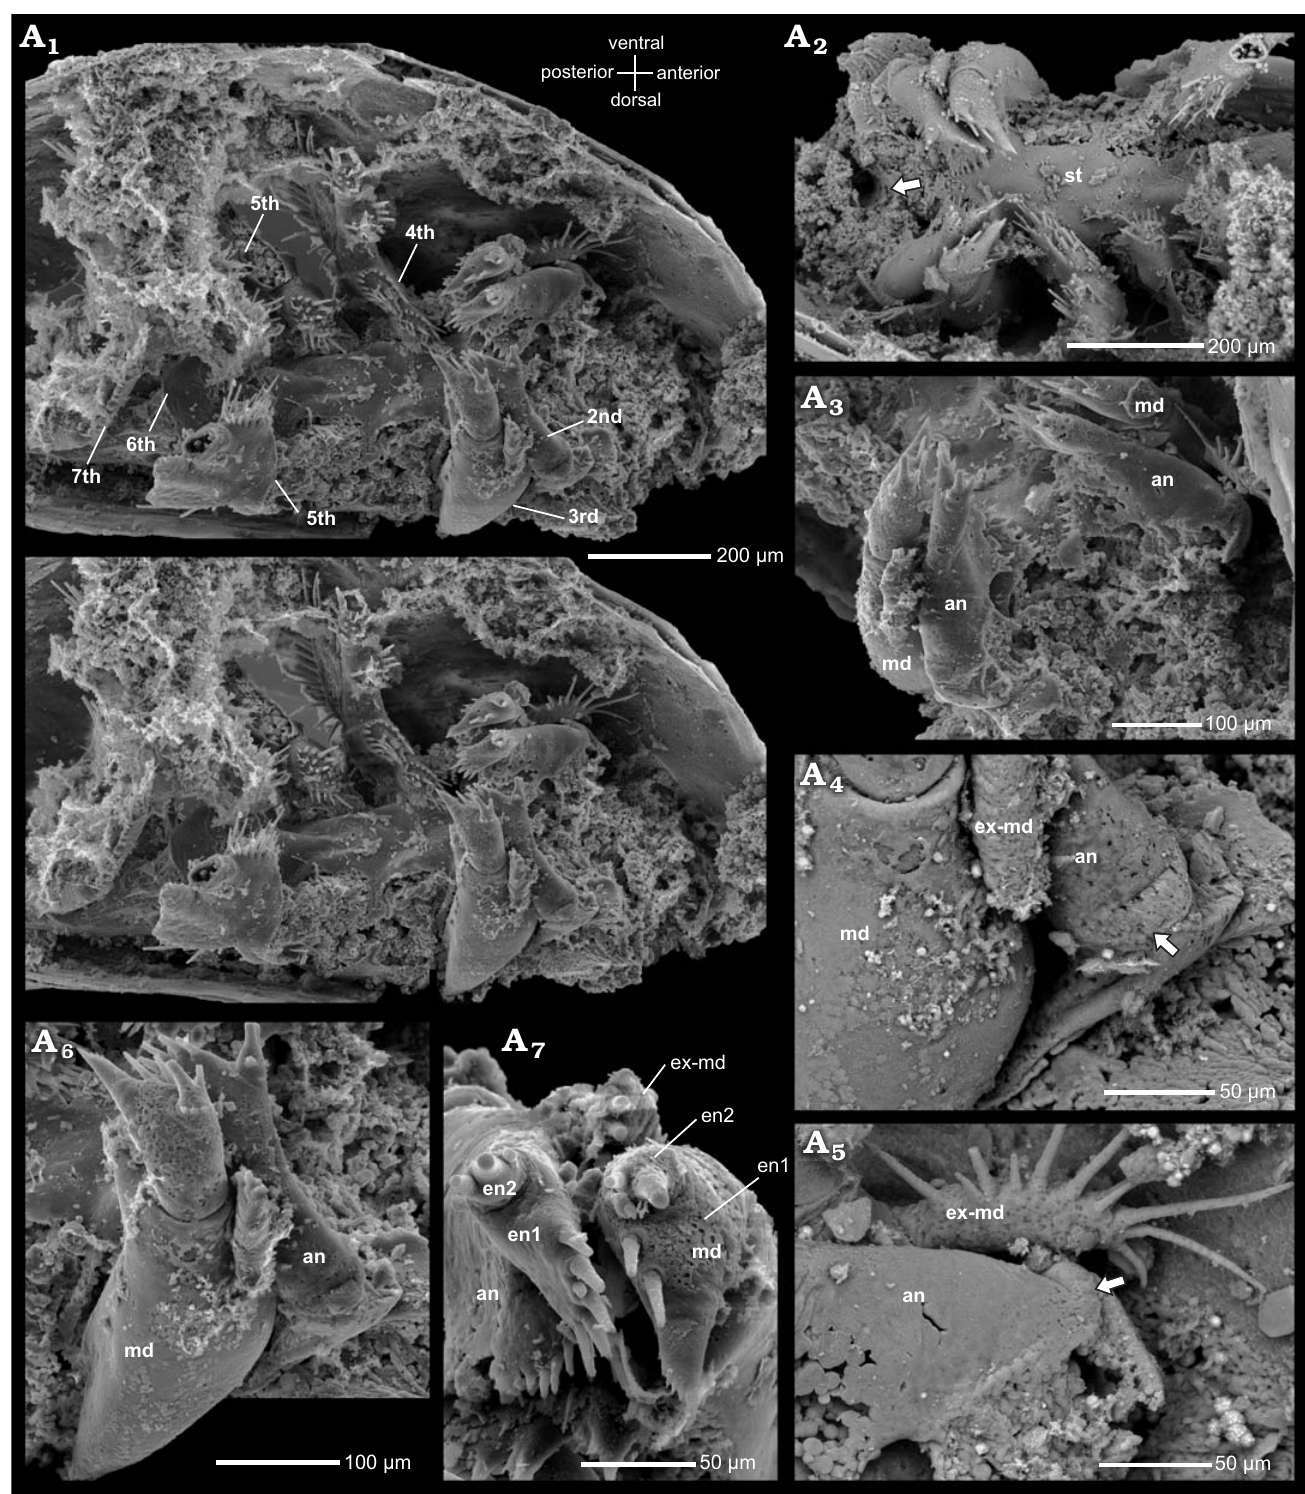
Fig. 3. Phosphatocopid crustacean Cyclotron angelini (Linnarsson, 1875), ZPAL Cr.11/ph060 from the Olenus Biozone, Furongian, D ę bki 2 borehole, northern Poland. Stereo-pair in ventro-lateral view side (A 1 ); ventral view exhibiting pairs of antennae and mandibles, first right post-mandibular limb and remains of second and third post-mandibular limbs, putative gut tube indicated by arrow, anterior to the left (A 2 ); pairs of antennae in anterior view, mandibles with reduced exopods partly visible (A 3 ); BSE image highlighting proximal part of the left antenna with ring-like structure at its base (arrow) (A 4 ); BSE image depicting proximal part of the right antenna in anterior view, with basal ring-like cuticular plate (arrow) (A 5 ); left mandible and antenna in postero-lateral view (A 6 ); left antenna and mandible in ventral view (A 7 ). Abbreviations: an, antenna; en, endopod; ex-md, exopod of the mandible; lst, limb stem; md, mandible; st,